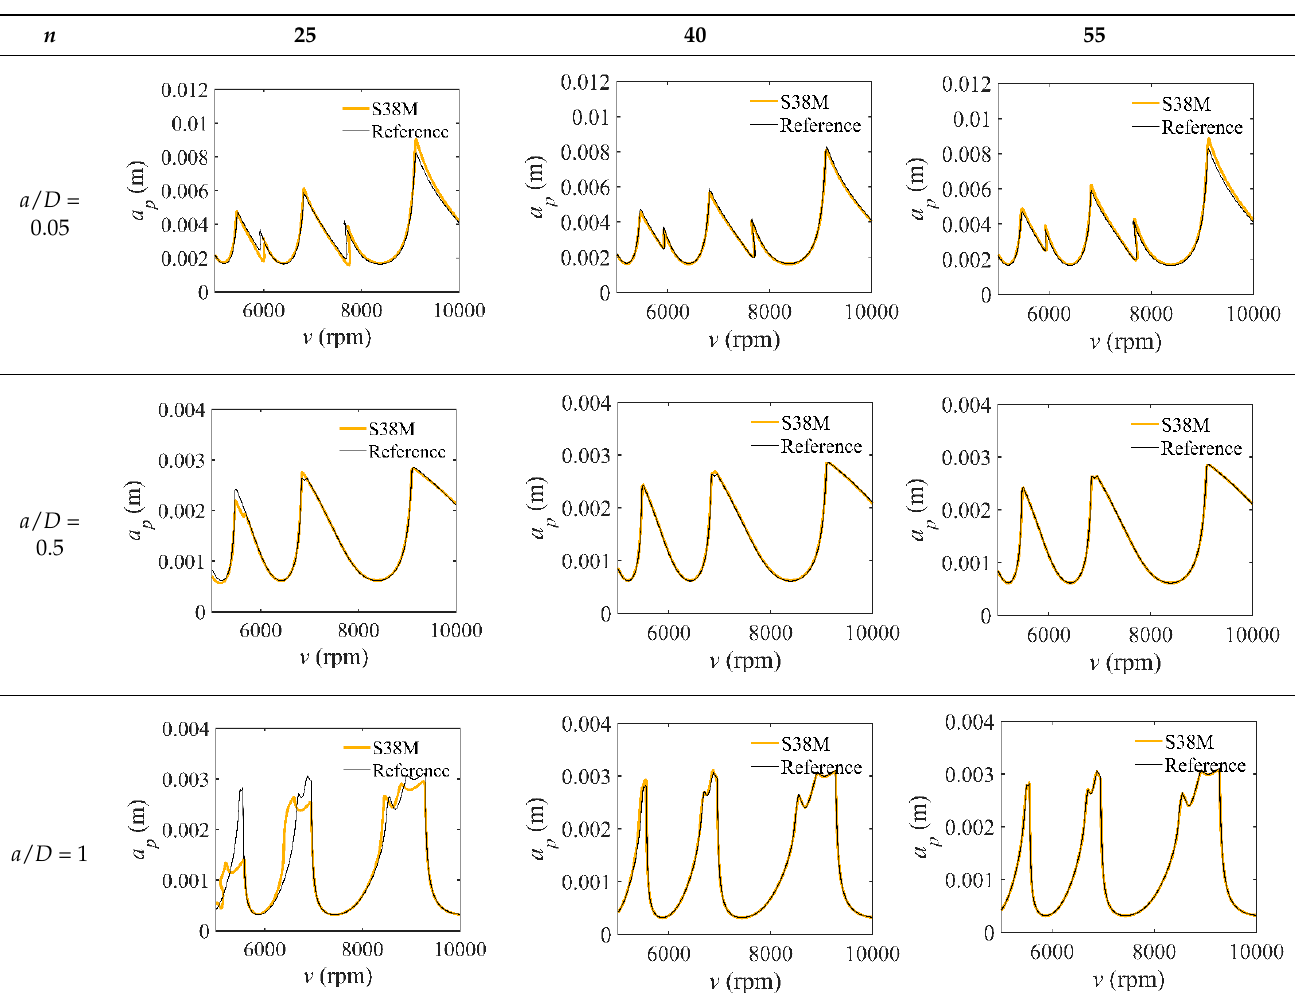
Table 4. Stability lobe diagrams of the S38M.